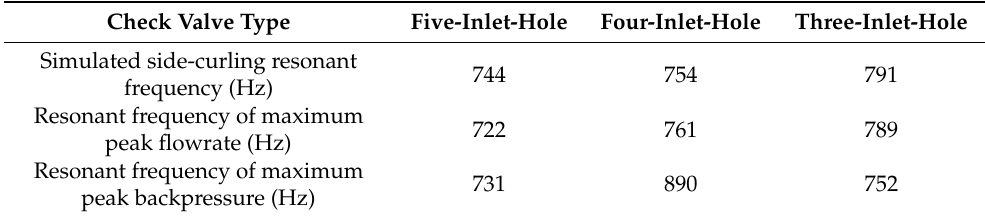
Table 2. Comparison of optimal operating frequencies between simulation and experiments. Check Valve